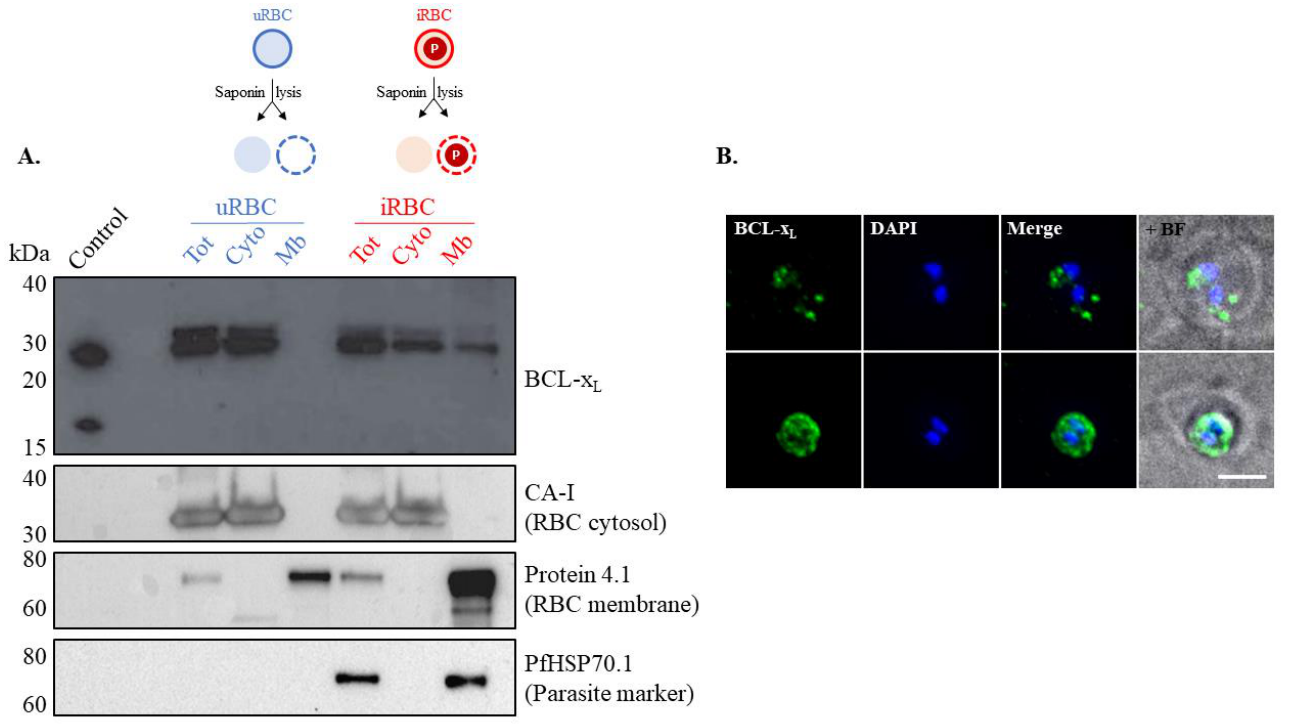
Figure 3. Subcellular localization of BCL-x L in uRBCs and iRBCs. ( A ) Representative Western blot of uRBCs or iRBCs: total protein extraction (tot), cytosolic content (cyto—soluble fraction of a saponin lysis), and membrane fraction (Mb—insoluble fraction of a saponin lysis). BCL-x L localizes exclusively to the cytosolic fraction in uRBCs and to the cytosolic and membrane fractions in iRBCs. A 16 kDa band corresponding to cleaved BCL-x L is observed in the control but not in the uRBC and iRBC fractions. The control sample corresponds to protein extracts derived from the breast cancer cell line MDA-MB 231. The same blot was successively probed with the following antibodies: anti- BCL-x L , anti-Carbonic Anhydrase I (CA-I), anti-protein 4.1, and anti-PfHSP70.1. CA-I, Protein 4.1, and PfHSP70 are markers for the RBC cytosol, the RBC membrane, and the parasite, respectively. Note: control panels are also used in another study focussing on the protein BAD (to be published elsewhere) ( B ) Immunofluorescence assay of iRBCs (two representative cells are shown: early and mid-stage of infection in the upper and lower panels, respectively). BCL-x L (green) is detected in the vicinity of the parasite, outside of the nucleus area stained with DAPI (blue) and inside the RBC membrane, which is visible by Bright Field (BF). The s cale bar is 4 μm.